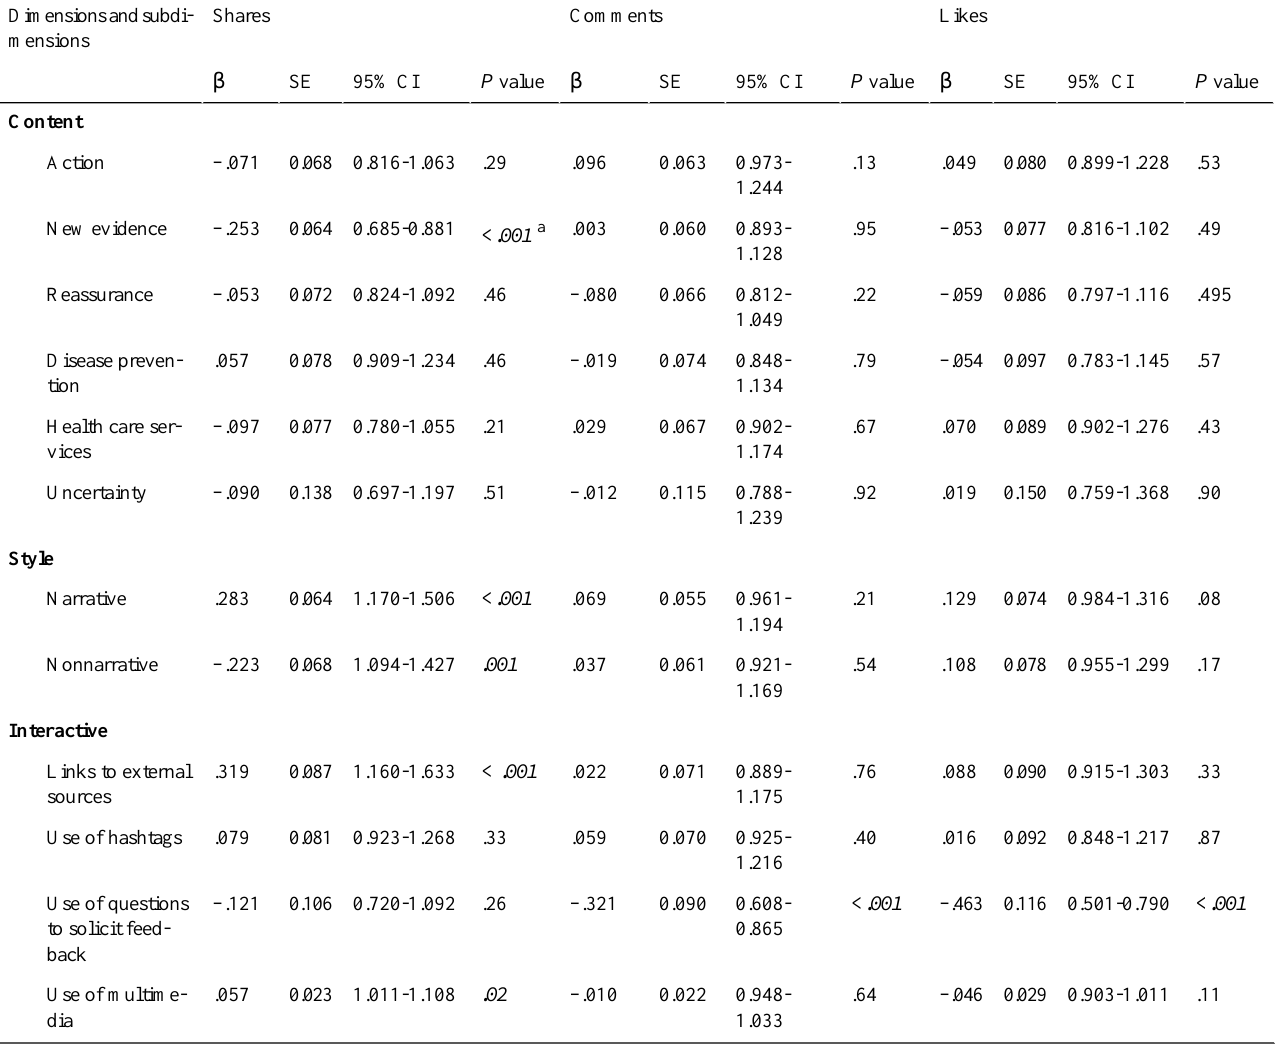
Table 1. Identification of positive and negative predictors of the number of shares, comments, and likes using a negative binomial regression model. LikesCommentsSharesDimensions and